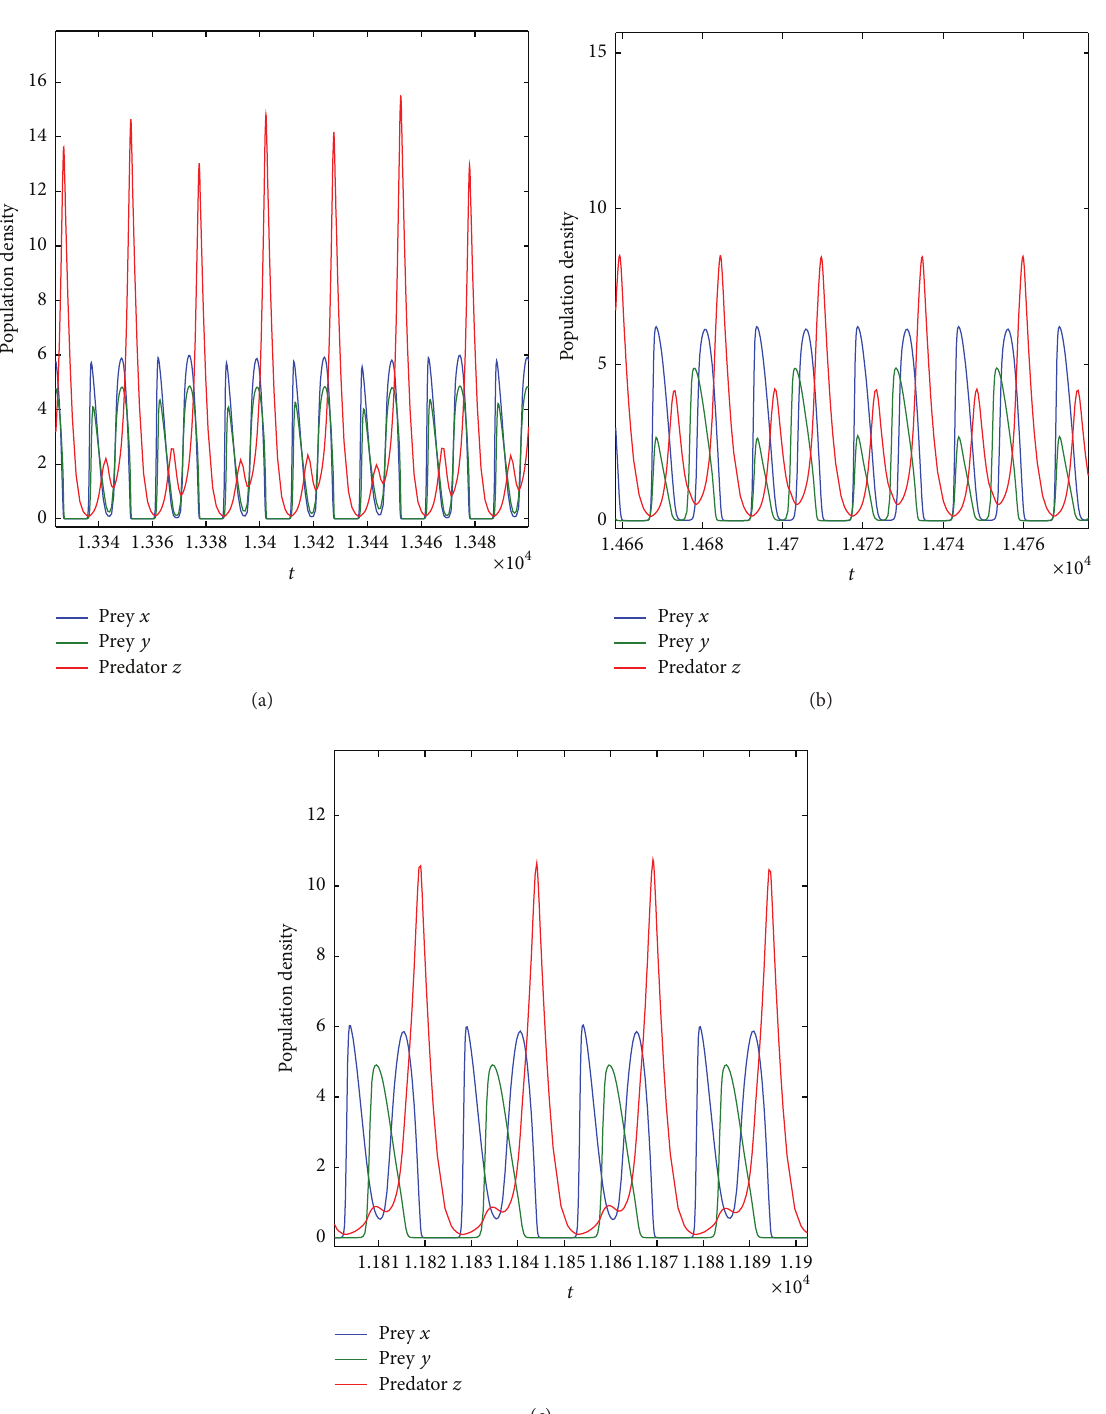
Figure 3: Solution trajectories of system (1) with mixed Holling type II–IV responses ( 𝑝 = 1 , 𝑞 = 1 , 𝑠 = 1 , and 𝑟 = 2 ) showing (a) in-phase synchronous variation for 𝜓 = 0 , (b) out-phase synchronous variation for 𝜓 = 𝜋/2 , and (c) antiphase synchronous variation for 𝜓 = 𝜋 with 𝜙 = 𝜋/2 and data set